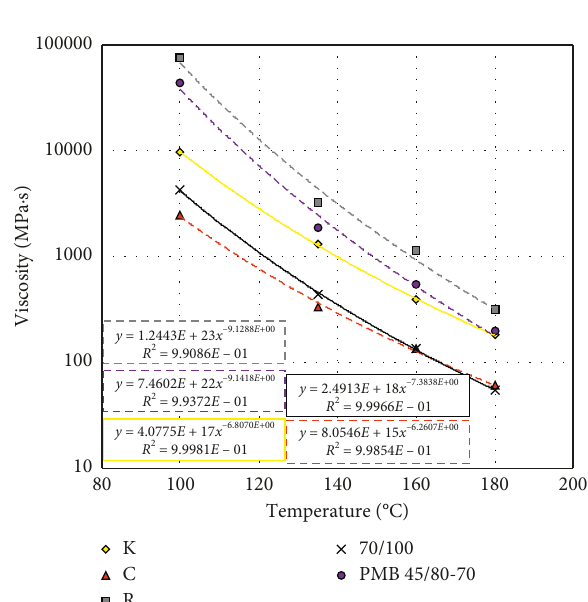
Figure 3: Viscosity values at high temperatures of tested